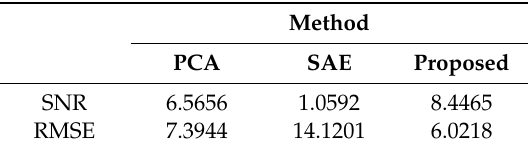
Figure 4. Comparison between the original wire rope images and their reconstructions. ( a ) The original wire rope images; ( b – d ) Images reconstructed by PCA, stacked autoencoder (SAE), and the proposed method, respectively. Table 1. Quantitative evaluation of wire rope image reconstruction. SNR: signal-noise ratio; RMSE: root mean squared